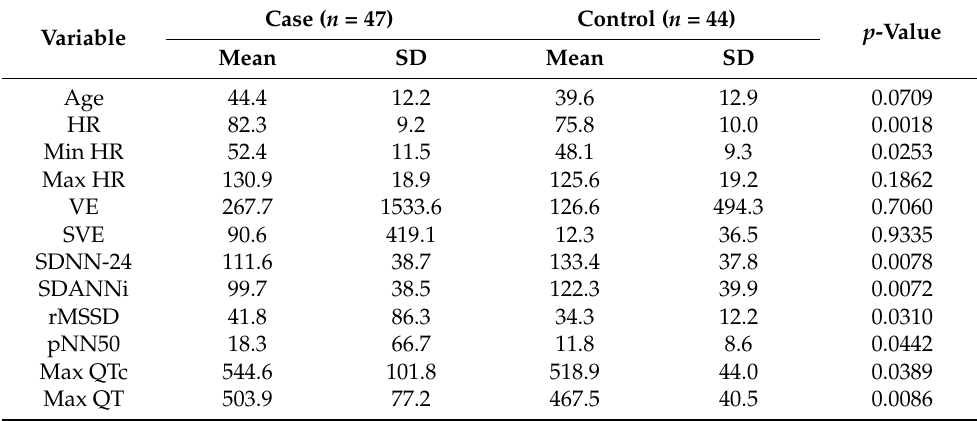
Table 4. Comparisons between the case and control